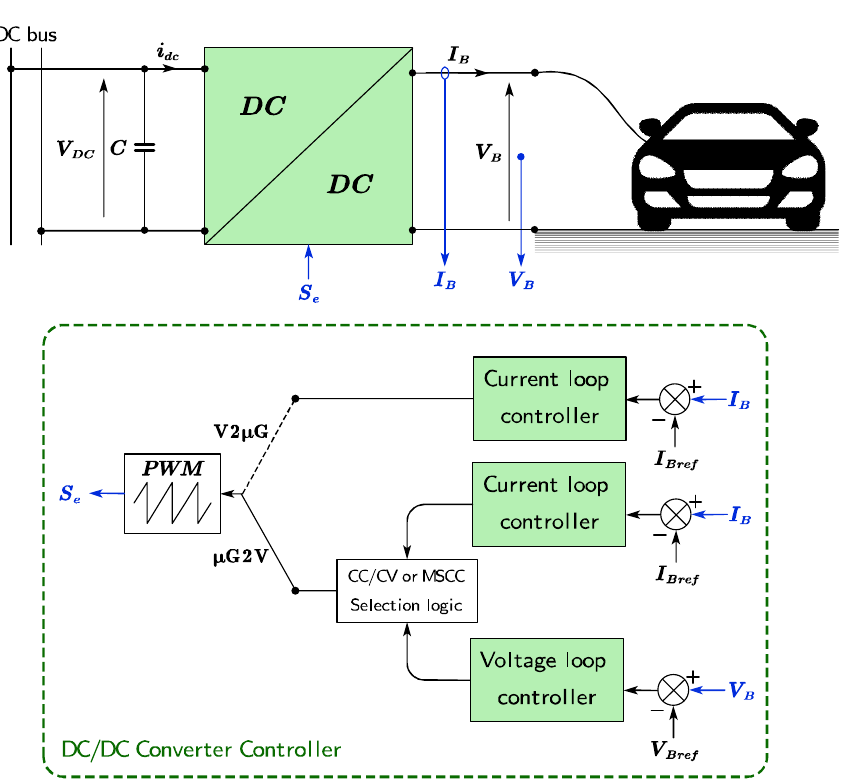
Figure 16. A control structural scheme of the ultra-fast charger integrated into the AC microgrid.